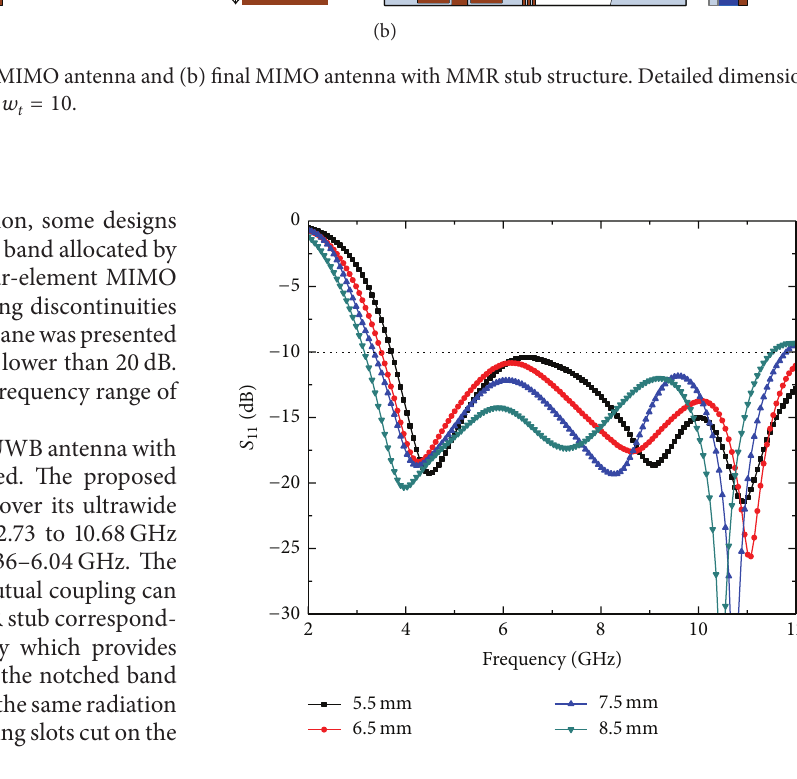
Figure 3: Simulated 𝑆 11 of the single UWB antenna without EBG structures for different parameters of 𝑅